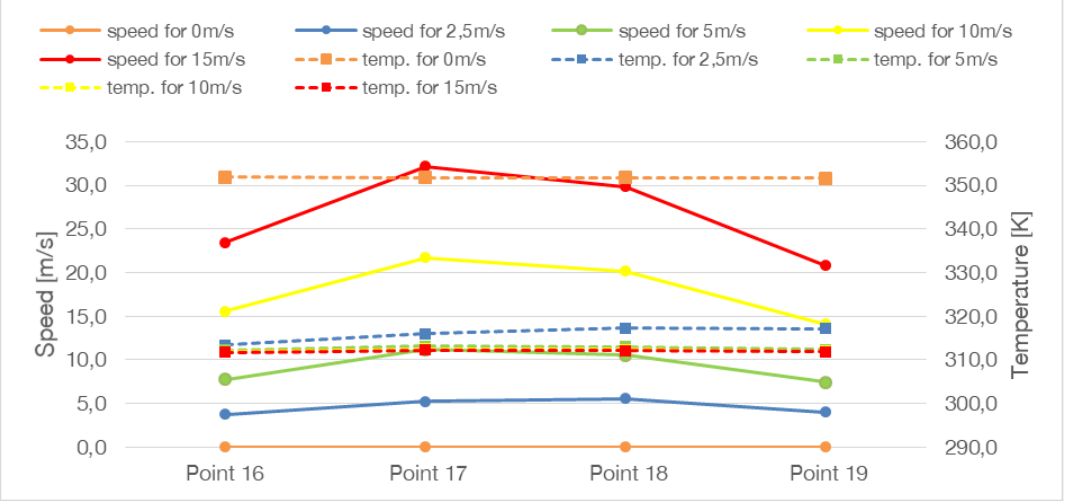
Figure 11: Compilation of temperature and airflow velocity for individual measurement points inside the ventilation space for a ventilated facade with closed